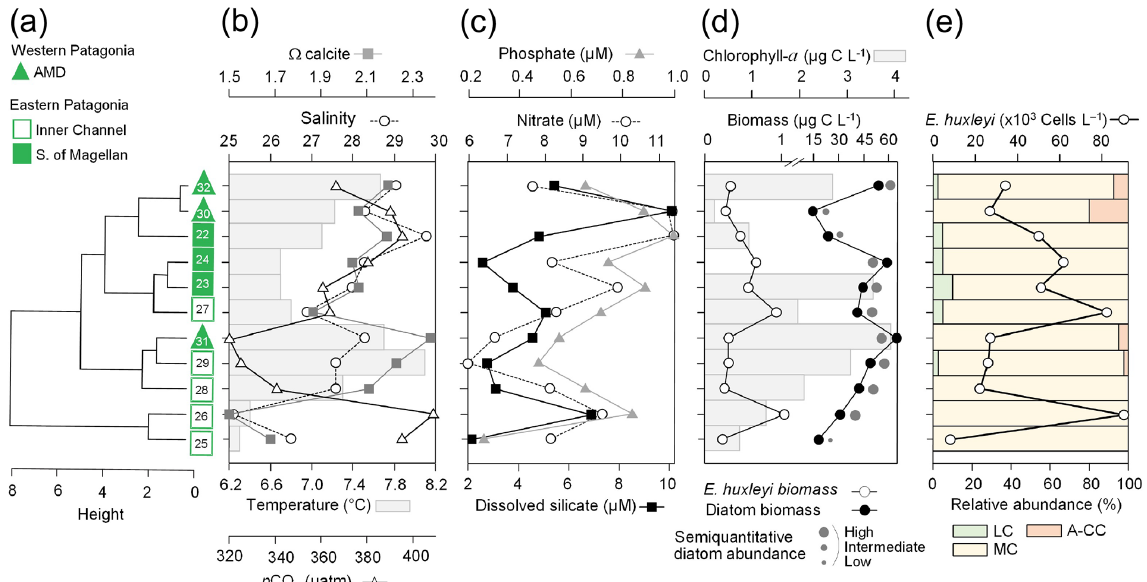
Figure 5. Physical, chemical, and nutrient conditions, chlorophyll- a levels, carbon biomass by E. huxleyi and diatoms, and abundances and calcification level of E. huxleyi recorded in surface waters of southern Patagonia during early austral spring 2017. (a) Hierarchical clustering on temperature, salinity, pH, p CO 2 , and (cid:127) calcite surface values on 11 water samples collected for plankton analysis; (b) salinity, temperature, (cid:127) calcite, and p CO 2 levels; (c) nitrate, dissolved silicate, and phosphate levels; (d) total chlorophyll a and total carbon biomass by E. huxleyi and diatoms and semi-quantitative estimation of diatom abundances (SEM); and (e) total abundances of E. huxleyi and relative abundances of three E. huxleyi morphotypes. All samples were taken < 5m in depth. Stations 25–26 and 30 were conducted at night. Morphotype abbreviations as in Fig.